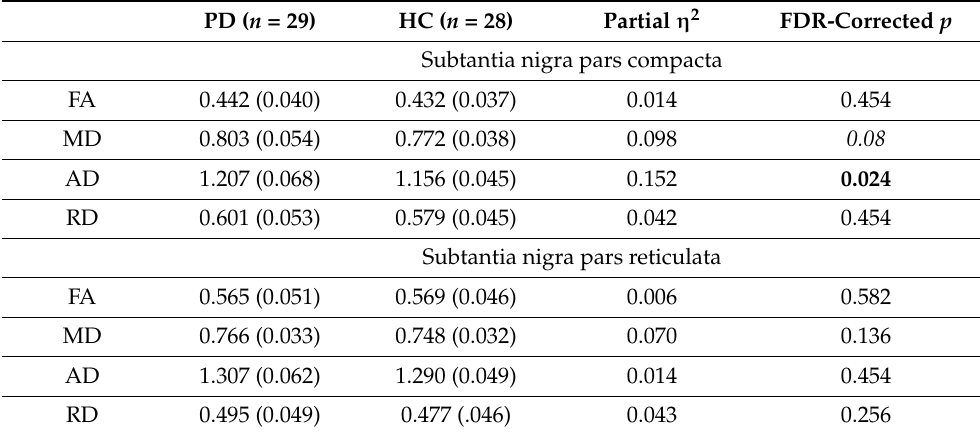
Table 2. Differences in diffusivity measures between PD patients and HCs.